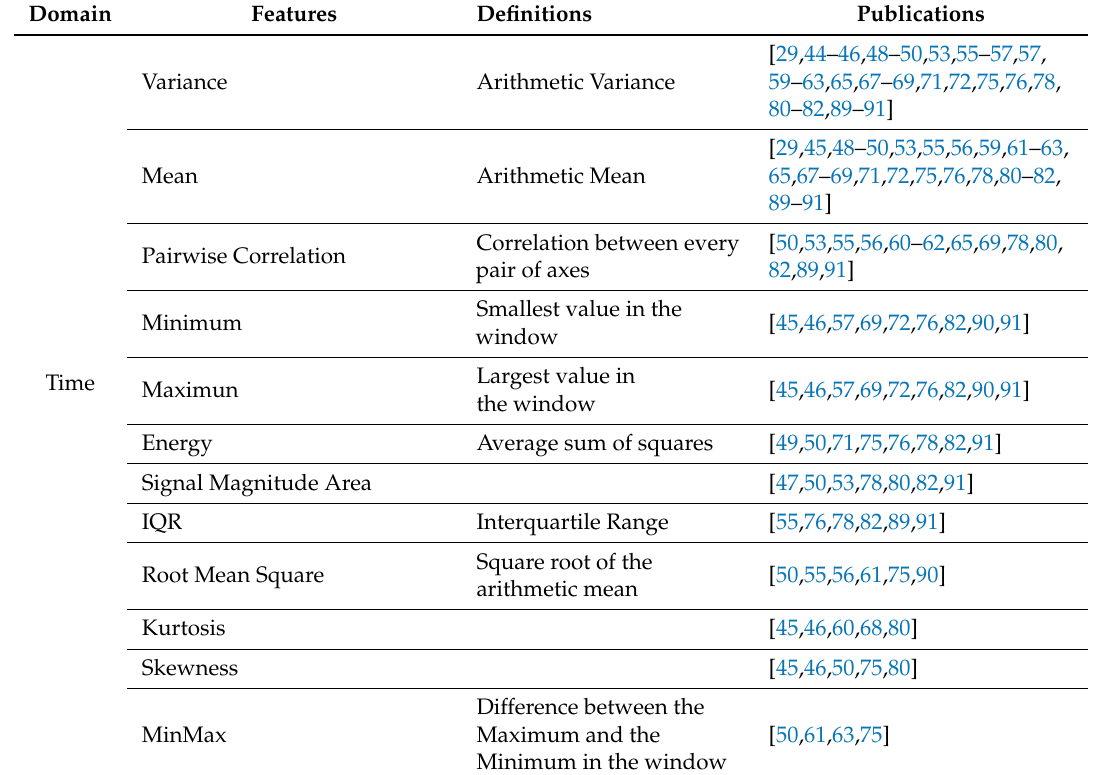
Table 11. Statistical features divided in two main groups: time and frequency